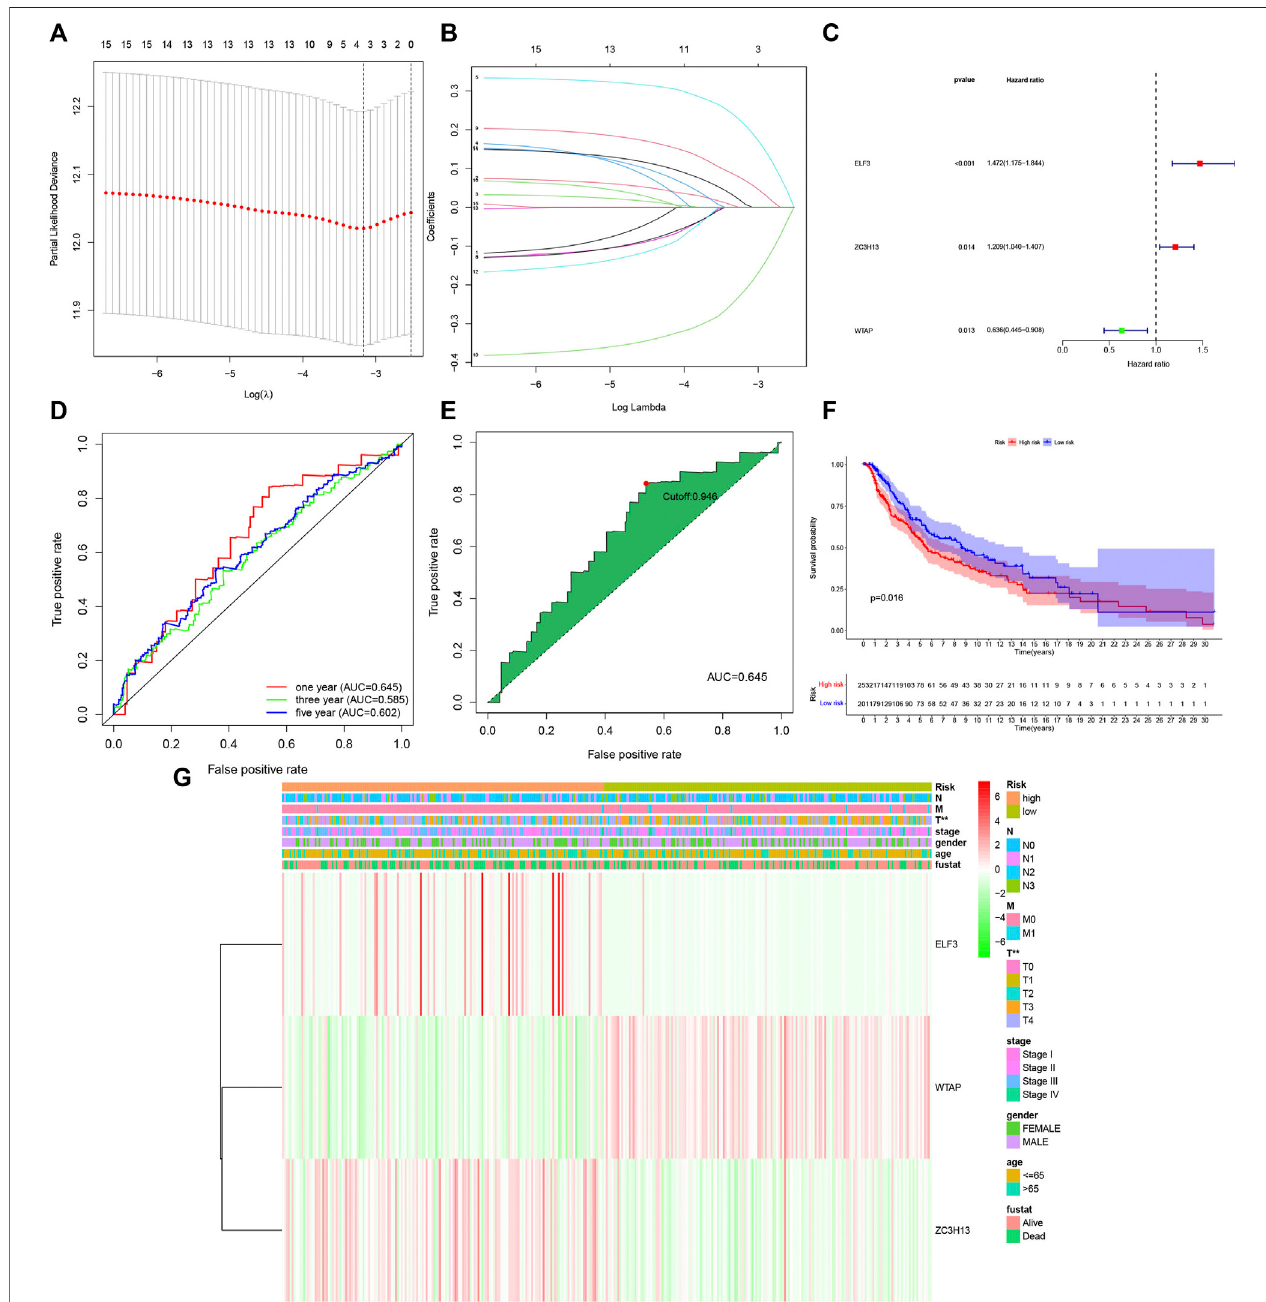
FIGURE 4| Construction ofthe three m 6 A RNAmethylation regulators-based risksignature. (A – B) Determination ofthe number of factors by the LASSOanalysis. (C) Multivariate analysis of the three-gene signature (ELF3,ZC3H13, AND WTAP). (D) Receiver operating characteristic (ROC) curves for 1-,3-,5-year prognosis. (E) 1 year was chosen to calculate the best cutoff value. (F) The kaplan-Meier curves of melanoma patients at the high-risk group and low-risk group in TCGA cohort. (G) Theexpressionfeaturesofthethreem 6 ARNAmethylationregulatorsandthedisteibutionofclinicopathologicalfeatureswerecomparedbetweenthelow-andhigh group of The Cancer Genome Atlas (TCGA) melanoma datasets. p < 0.01 ( “ ** ” ).